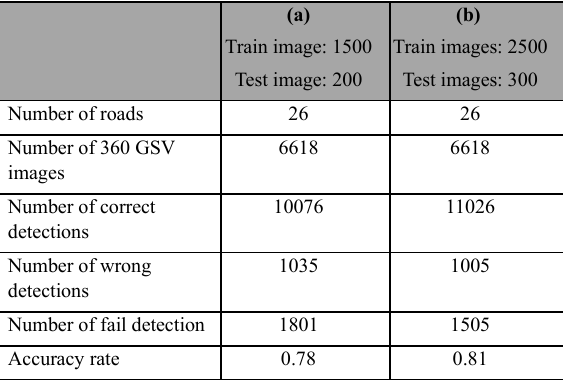
Table 1. Summary of YOLOv3 network training and detection with different training set